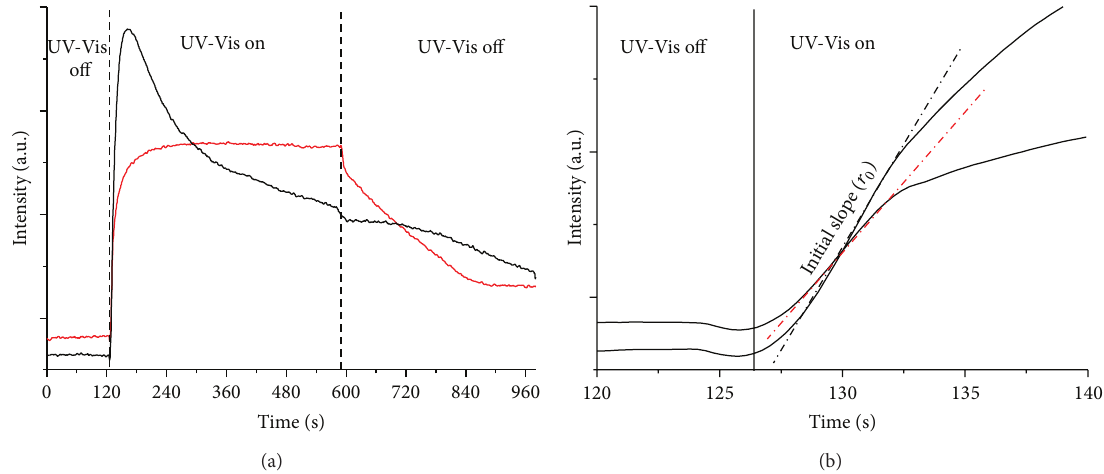
Figure 8: (a) Time course of the ∙ DMPO-OH signal maximum before and during UV-Vis irradiation for TiO 2 (black line) and TS (red line) samples; (b) magnification of the initial portion of the curve for which the initial slope ( 𝑟 𝑜 ) was taken as representative parameter to evaluate the initial rate of OH ∙ , O 2 −∙ , and 1 O 2 generation.